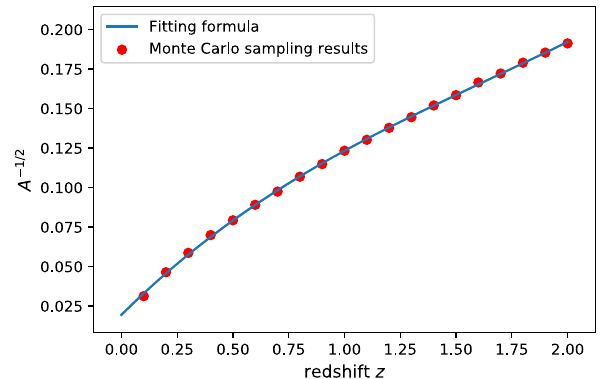
Fig. 5 The fitting formula A − 1 / 2 ( z ) as a function of redshift z . The red dots arise from the Monte Carlo simulation, while the blue solid curve denotes a fitting formula in Eq. (30)